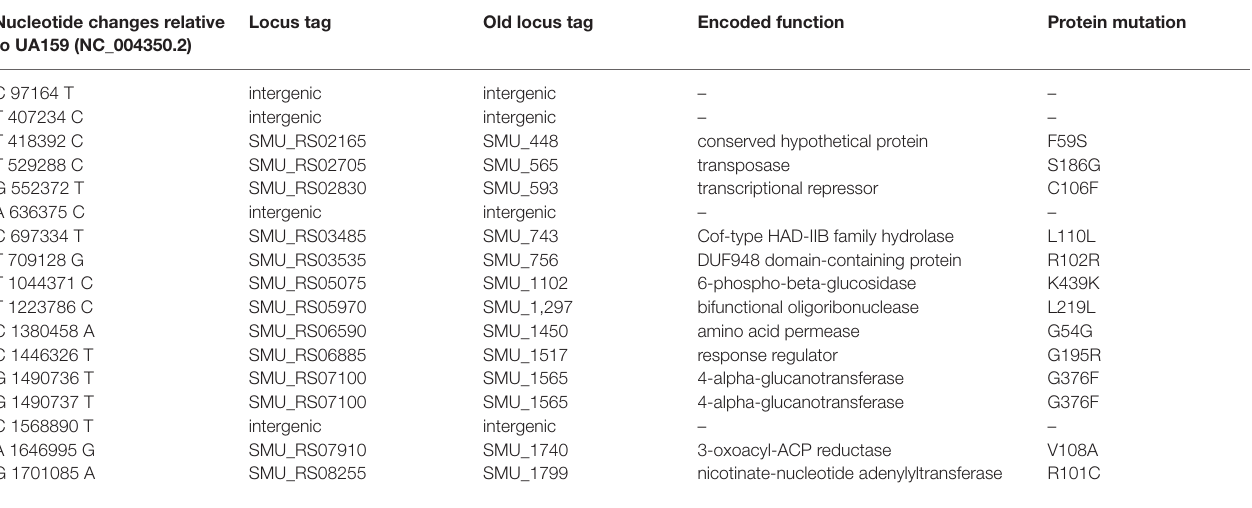
TABLE 1 | Summary of single nucleotide polymorphisms (SNPs) detected in the ftsH suppressor strain (S876). Nucleotide changes relative to UA159